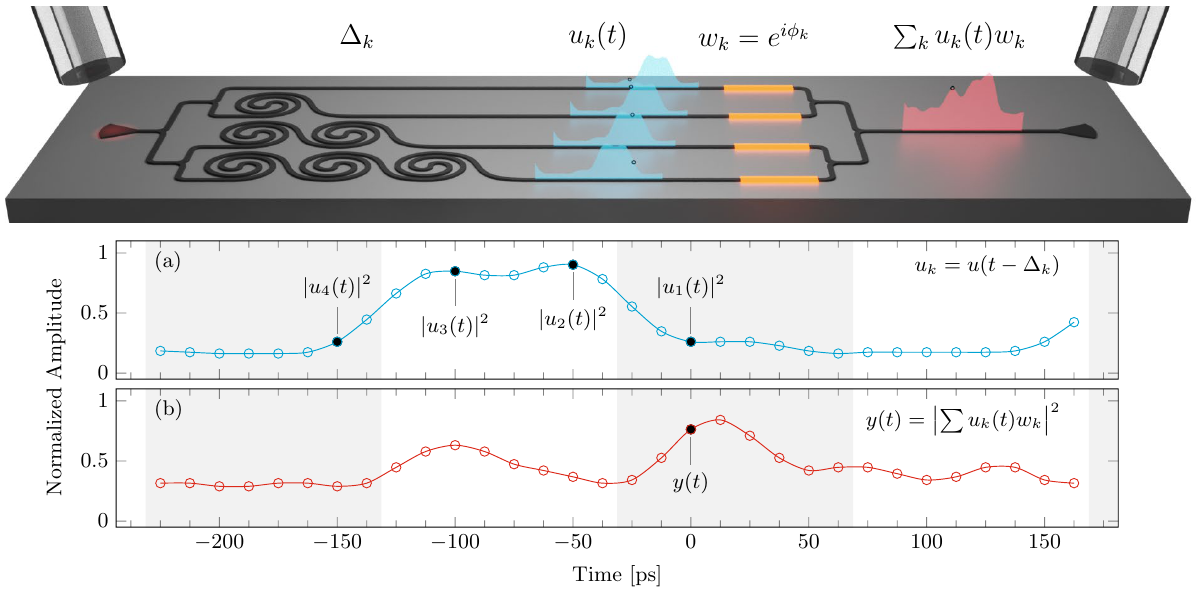
Figure 1. (Top) Sketch of the integrated photonic circuit which performs as a complex perceptron. Gratings are used to couple the light in and out of the chip. The red spot on the left shows the input signal. A 1 × 4 splitter distributes the input signal to four delay lines, realized by spirals (each spiral adds a delay of (cid:31) t ). Then, thermal i φ k phase modulators (yellow segments) allow controlling the relative phases ( w k = e ) of the signals ( u k ( t ) , blue lineshapes). These are then summed by combiners and the resulting signal ( y ( t ), red lineshape) is output via a grating. (Bottom) ( a ) Input signal versus time. The black circles show the sampling of the input signal done by the four delay lines. ( b ) Perceptron output versus time. This signal is the one that results after the photodetector. The dot shows the time at which the complex sum is